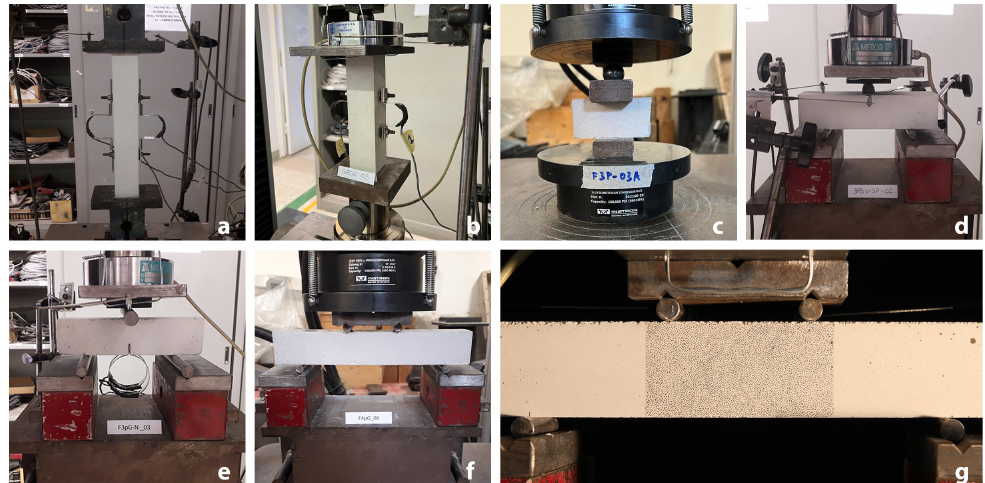
Figure 3. Test set ups: ( a ) uniaxial tensile for the determination of Young’s modulus in tension, ( b ) compression for the determination of Young’s modulus in compression, ( c ) compression for the determination of compressive strength, ( d ) three-point bending, ( e ) three-point bending with a notched specimen, ( f ) four-point bending, ( g ) four-point bending with measurement DIC system